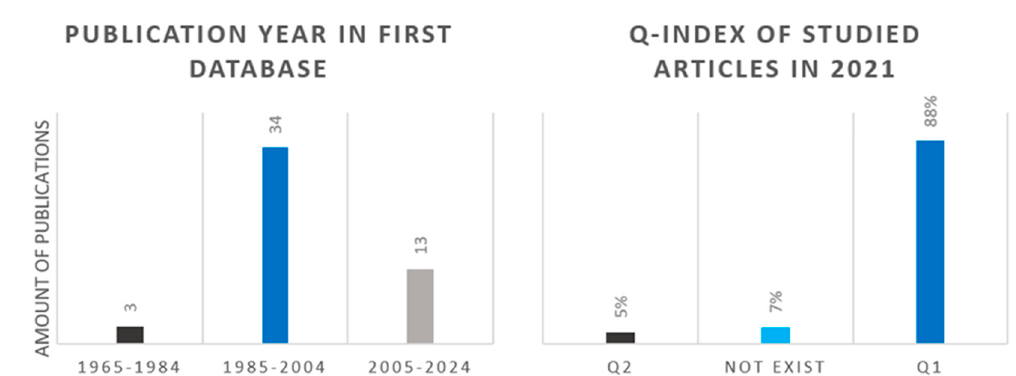
Figure 8. Publication year distribution of 56 articles after first selection ( left ) and Q-index distribution of 15 articles after second selection ( right ) .